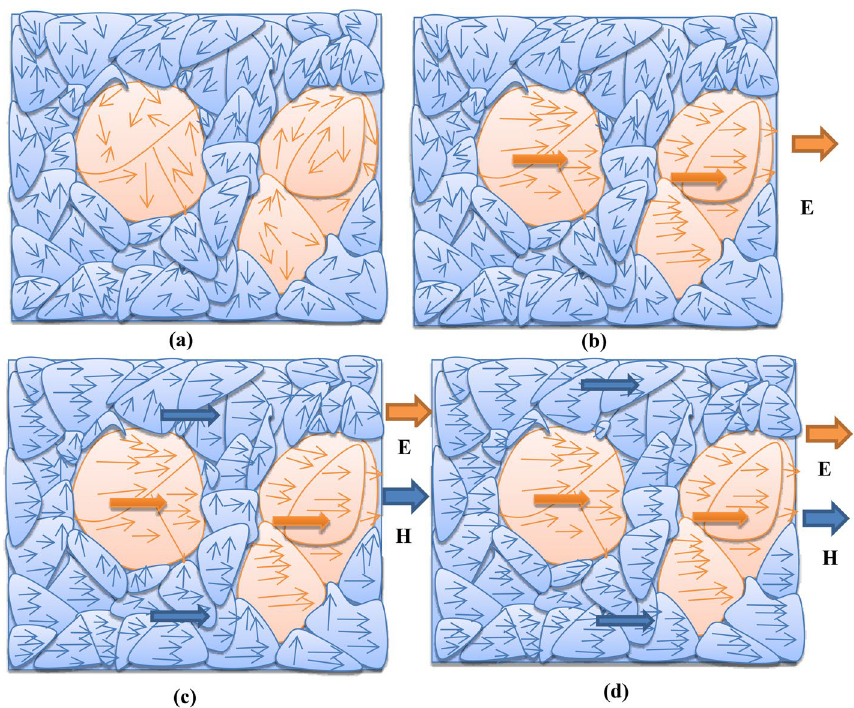
Figure 8. Schematic representations of evoluation of magnetic (blue colour) and electric (orange colour) domains for different magnetic